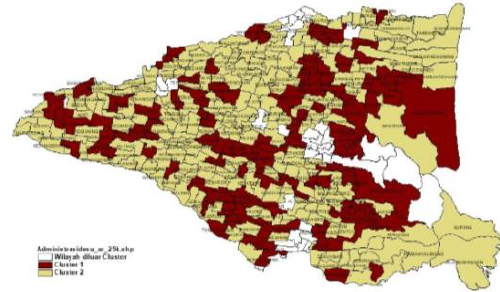
Figure 2: Clustering of Villages Based on Environmental